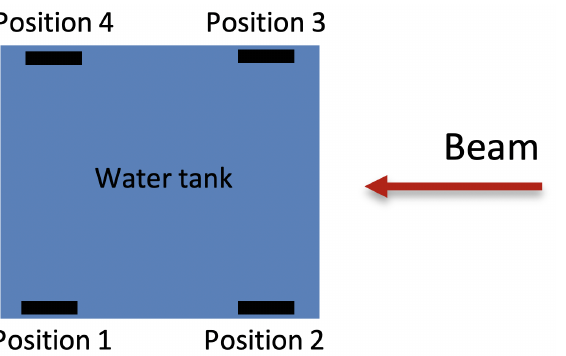
Figure 6. Four different irradiation configurations, each for one electrode position in the water phantom (view from the top).